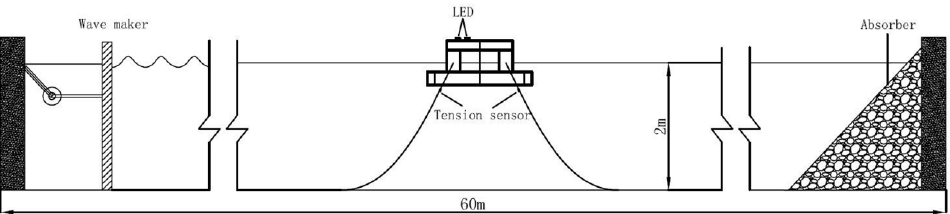
Figure 8. The sketch of the layout of the wave tank tests of the semi ‐ submersible platform.